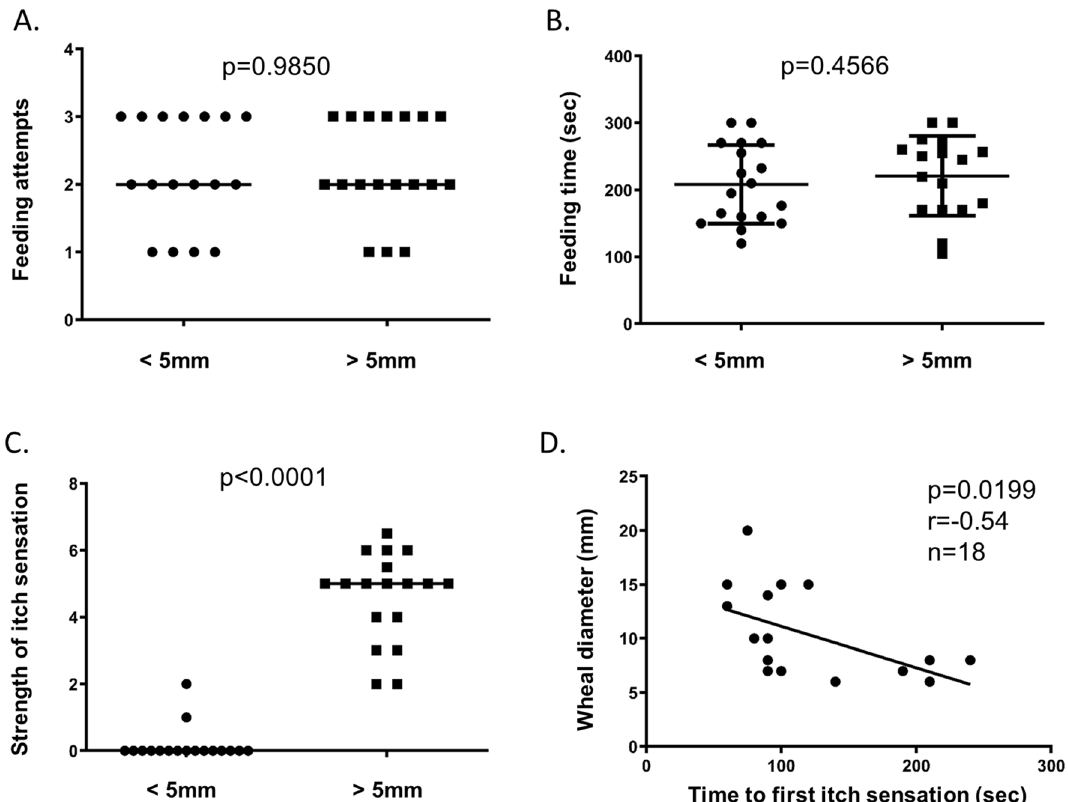
Figure 1. Mosquito saliva-induced type I hypersensitivity induces strong itch sensation in humans. Three mosquitoes were allowed to feed on the left forearms of non-sensitive (< 5 mm) and hypersensitive (> 5 mm) human participants. ( A ) The number of mosquitoes that attempted to feed per human participant were quantified. ( B ) Mosquitoes were given five minutes to feed on human participants once probing initiated and the feeding time was quantified in seconds. The average feeding times per human participant are shown. ( C ) The strength of the itch sensation experienced by non-sensitive and hypersensitive human participants was rated on a 0–10 scale. ( D ) Correlation analysis was performed between the wheal diameter and the time to first itch sensation in hypersensitive participants. Significance ( p ), Pearson’s coefficient ( r ), and total number of hypersensitive individuals (n) are shown. Statistical significance between groups was determined after testing for normal distribution using the Kolmogorov–Smirnov test. Student’s t tests were used for normally distributed data. Mann–Whitney tests were used for data that was not normally